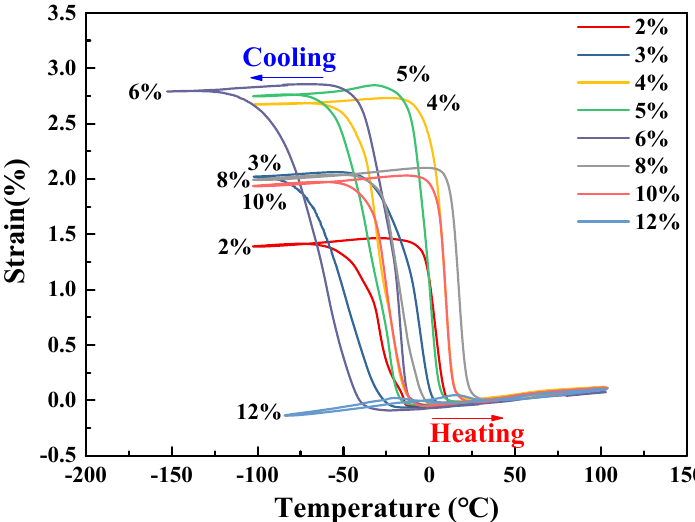
Figure 7. TWSME exhibited in thermal cycles after different cryogenic pre-deformations of columnar-grained Cu 71.7 Al 18.1 Mn 10.2 alloy samples.